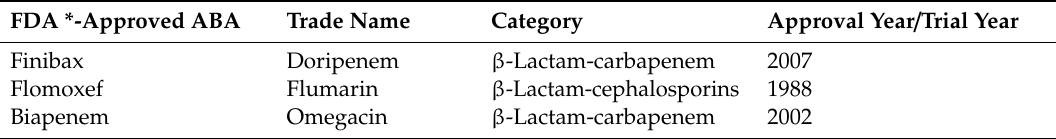
Table 1. Antibacterial